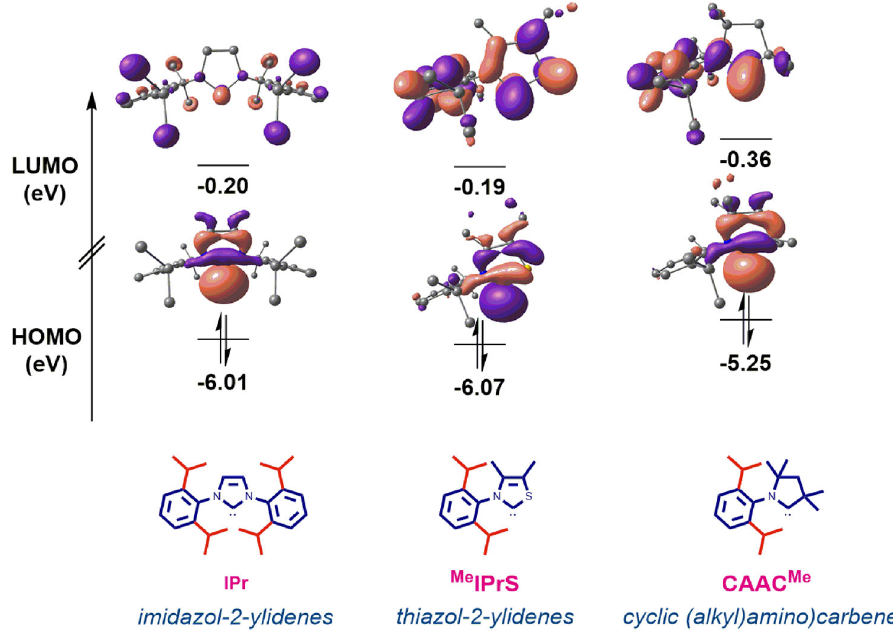
Fig. 10 HOMO and LUMO energy levels (eV) calculated at B3LYP 6-311 + + g(d,p). See Supplementary Note 3 for